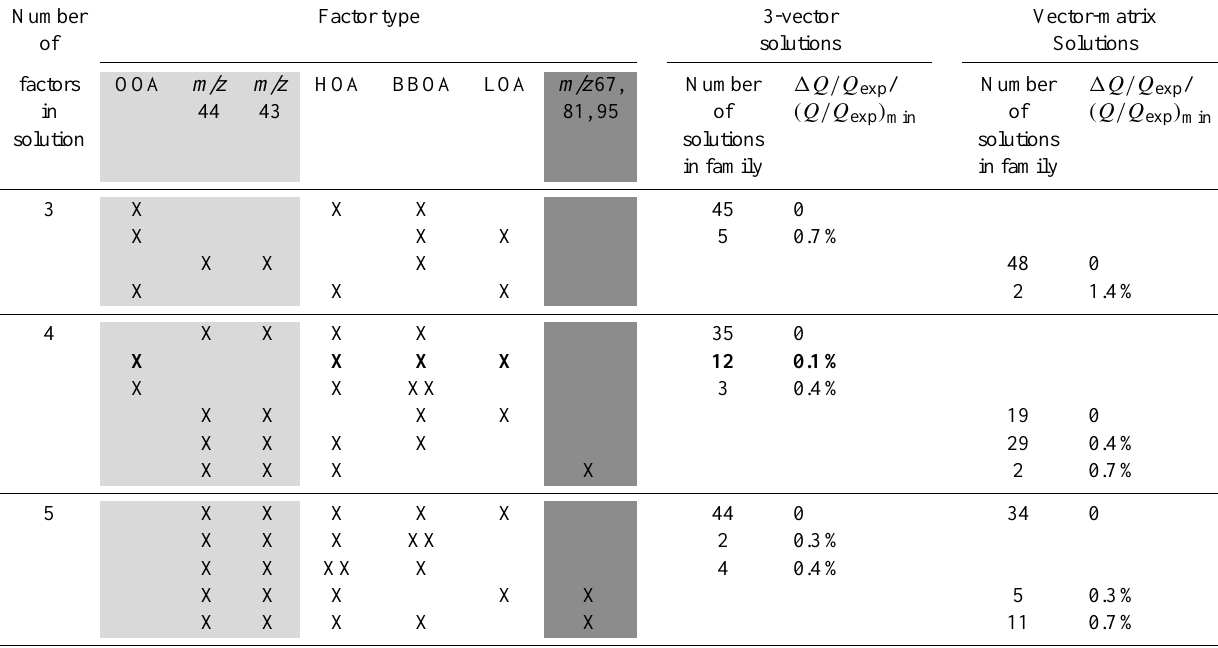
Table 3. Types of factors identified in each solution family from 50 “seed” trials of the 3-vector and vector-matrix models solved by ME-2. Each row represents one family of solutions, and each X represents one factor in a solution. Multiple Xs in one entry denote multiple instances of this factor in the same solution. These factors usually have similar mass spectra but different size distributions and time series (Fig. S6 in the Supplement). The columns with grey shading represent factors related to oxygenated organic aerosol (OOA). Each solution contains one OOA factor or two factors dominated by m/z 44 and m/z 43. The column with darker grey shading represents factors that are dominated by m/z ’s67, 81, and 95. These factors are not physically meaningful. The best solution of the 3-vector model has four factors and is shown in bold. No solutions of the vector-matrix model were considered physically